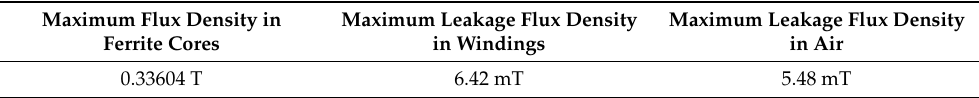
Table 8. Maximum magnetic flux densities at different positions.